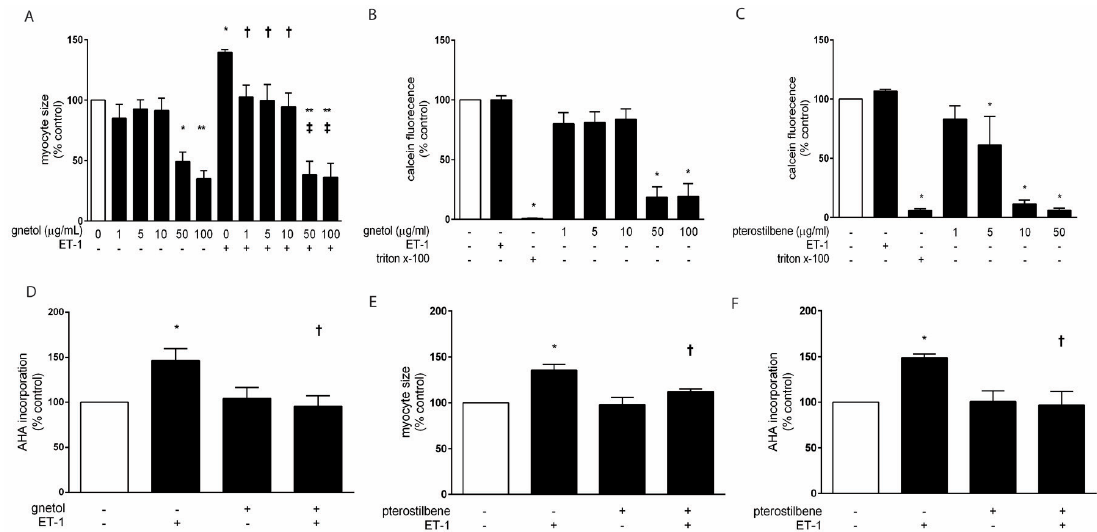
Figure 1. Effects of gnetol and pterostilbene on cardiomyocyte hypertrophy and viability. ( A ) The ability of ET1 (0.1 µ M; 24 h) to induce myocyte enlargement was abolished by lower concentrations of gnetol (1–10 µ g/mL), whereas higher concentrations of gnetol (50–100 µ g/mL) reduced cell size in the presence and absence of ET1. n = 3; 40–45 myocytes/group. * p < 0.05 and ** p < 0.01 vs. control (open bars); † p < 0.05 and ‡ p < 0.01 vs. ET1. The effects of gnetol and pterostilbene on cardiomyocyte viability were therefore determined using triton x-100 as a positive control of reduced cardiomyocyte viability; ( B ) Lower concentrations of gnetol (1, 5, and 10 µ g/mL) exhibited no adverse effects on calcein fluorescence (an indicator of viable cardiomyocytes), whereas higher concentrations (50 and 100 µ g/mL significantly decreased viability. n = 3–4. * p < 0.05 vs. control (open bars); ( C ) only 1 µ g/mL of pterostilbene exhibited no adverse effects on viability, whereas higher concentrations (5, 10 and 50 µ g/mL) significantly decreased calcein fluorescence. n = 3–4. * p < 0.05 vs. control (open bars); ( D ) A sub-maximal concentration of gnetol (5 µ g/mL) blocked ET1-induced protein synthesis (measured as L -azidohomoalanine [AHA] incorporation), a second marker of hypertrophy. n = 3; * p < 0.05 vs. control (open bars); † p < 0.05 vs. ET1. The ability of ET1 (0.1 µ M; 24 h) to induce; ( E ) myocyte enlargement and ( F ) protein synthesis (i.e., AHA incorporation) was abolished by pterostilbene (1 µ g/mL). n = 3; 40–45 myocytes/group. * p < 0.05 vs. control (open bars); † p < 0.05 vs.